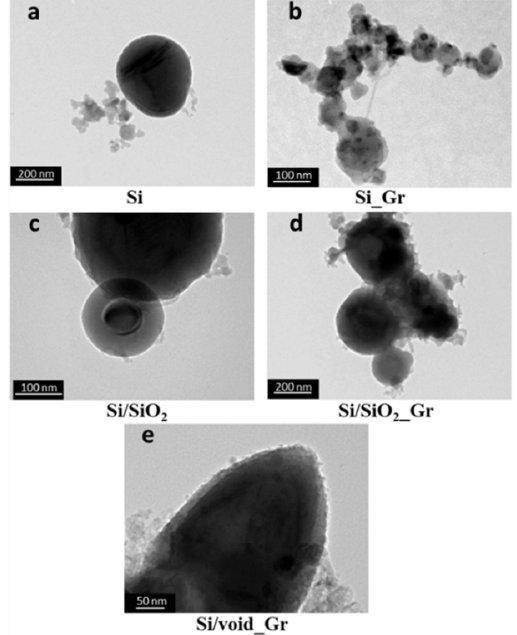
Figure 2. TEM images of the different silica nanoparticles-based samples listed in Table 1, of ( a ) Si, ( b ) Si _Gr, ( c ) Si/SiO 2 _Gr, ( d ) Si/SiO 2 _Gr, and ( e ) Si/void_Gr.